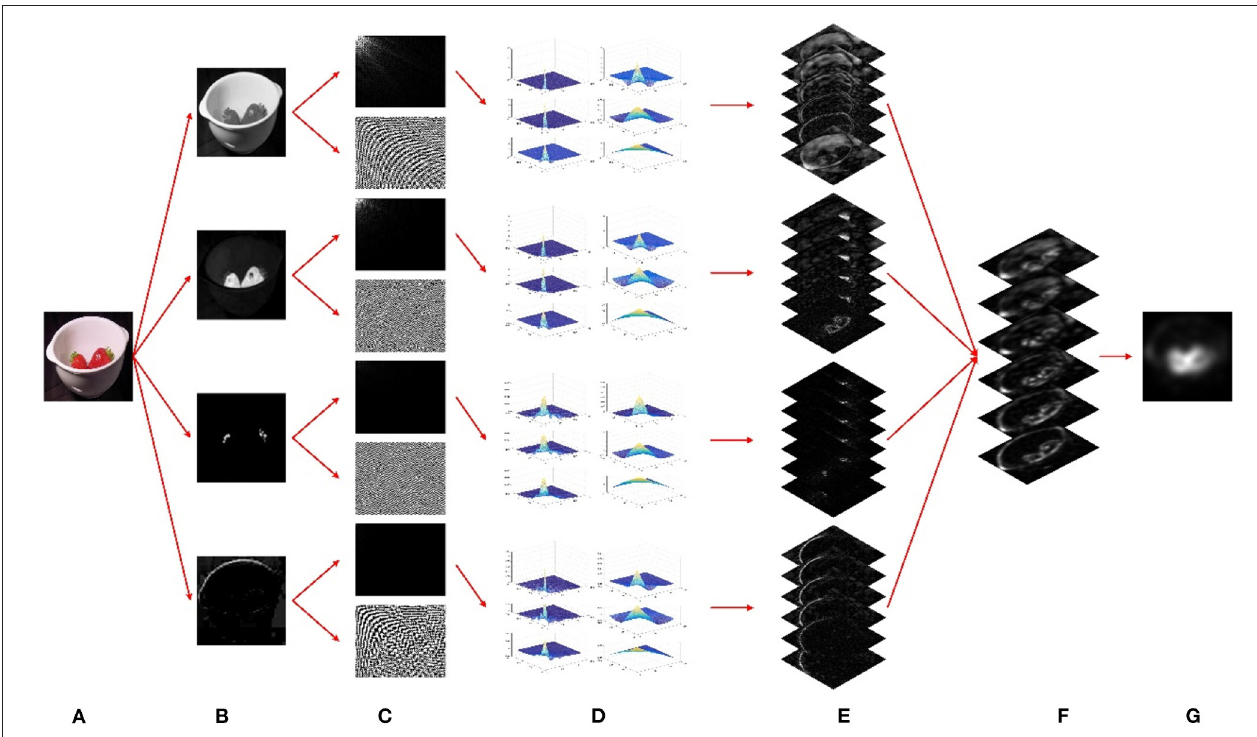
FIGURE 1 | An illustration of our model for saliency detection. (A) Input image. (B) Four general-tuned visual channels. (C) Discrete cosine transform (DCT) magnitude spectra and corresponding signum spectra. (D) Wavelet decomposed multiscale magnitude spectra for every single channel. (E) Six multiscale conspicuity maps for every single channel. (F) Six multiscale saliency maps after channel-wise integration. (G) A final saliency map after scale-wise